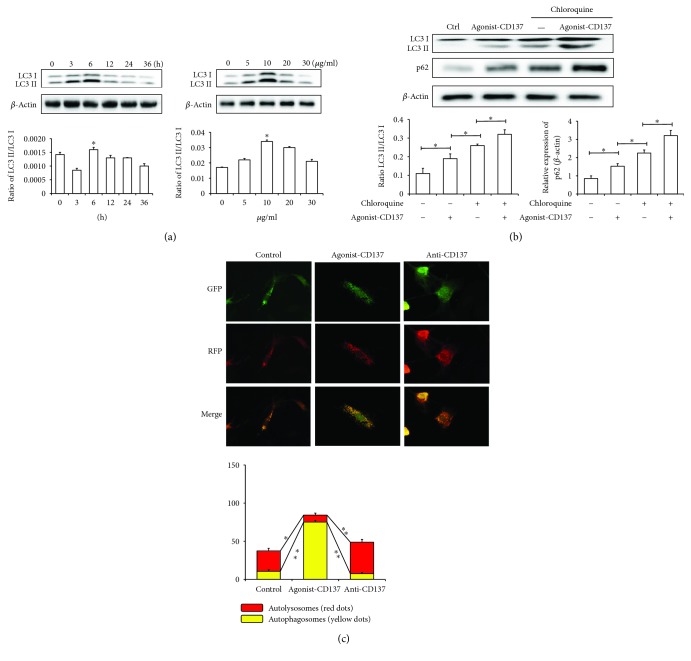
CD137 signaling induced VSMC autophagy. (a) Primary mouse aortic VSMCs were stimulated by recombinant protein of agonist-CD137 (10 μg/ml) for different concentrations and time. Western blot was applied to measure the expression of LC3B after treatment. (b) VSMCs were treated with CQ (10 μmol/L) 15 min before agonist-CD137 treatment for 6 h followed by protein extraction for Western blot analyses of p62 and LC3B. (c) Image showing LC3B staining in each group of VSMCs infected with mRFP-GFP-LC3 adenovirus for 6 h. Data are expressed as the mean ± SEM of at least three independent experiments. ∗ refers to P < 0.05; ∗∗ refers to P < 0.01.